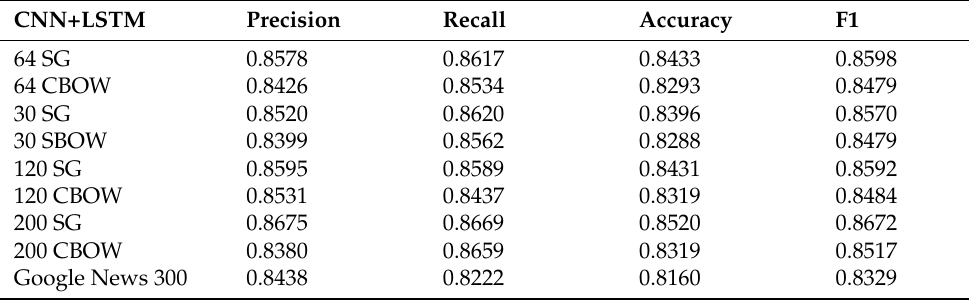
Table 6. Effectivity of CNN+LSTM model with the topology presented in the Table 5.